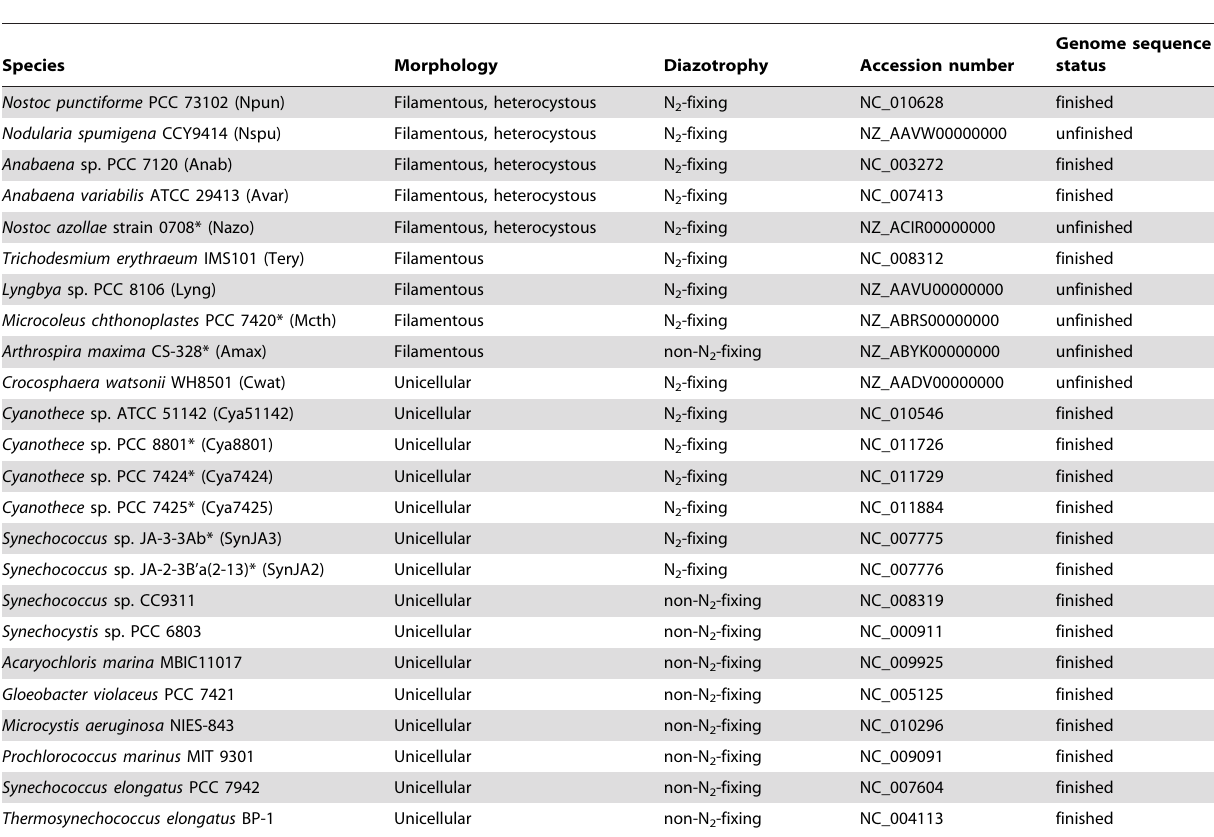
*Species included in the second part of the analysis. Figure S1 Size estimation of D9 and CS-505 genomes by PFGE restriction analysis. Restriction profiles were obtained by Mlu I digestion. SC: Chromosomic DNA from Saccharomyces cerevi- siae. Vpkx: Genomic DNA from Vibrio parahaemolyticus RIMD 2210633 digested with Not I. PFGE electrophoresis conditions are described in Stucken et al., [22]. Figure S2 Possible extrachromosomal element in the CS-505 genome. PFGE of chromosomic DNA from strains D9 and CS- 505, the possible plasmid is indicated by the arrow. SC: Chromosomic DNA from Saccharomyces cerevisiae. Figure S3 Distribution of the total unique CDS of CS-505 and D9 into Cluster of Orthologous Groups (COGs). Unique CDS were obtained by a Best-Bidirectional Hits (BBHs) search between both genomes using a 30% cutoff. Figure S4 Repeated sequences in a repeat unit as revealed by an analysis using miropeats. The analysis was performed according to Parsons, (1995), with a threshold score of 100 [58]. Figure S5 Structure and comparison of the toxin gene clusters in CS-505 and D9 with those previously described. A. Comparison of